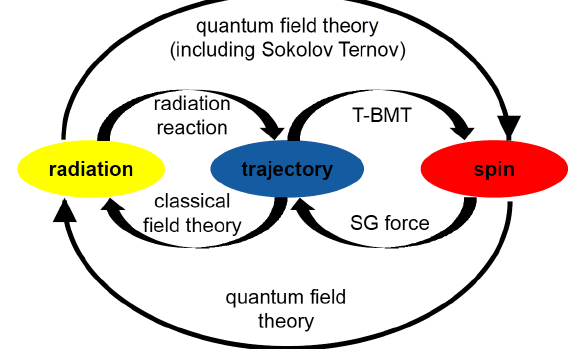
FIG. 1. Schematic overview of relations between single particle trajectory (blue), spin (red) and radiation (yellow). The black arrows indicate the basic physical process that links two of these fields.